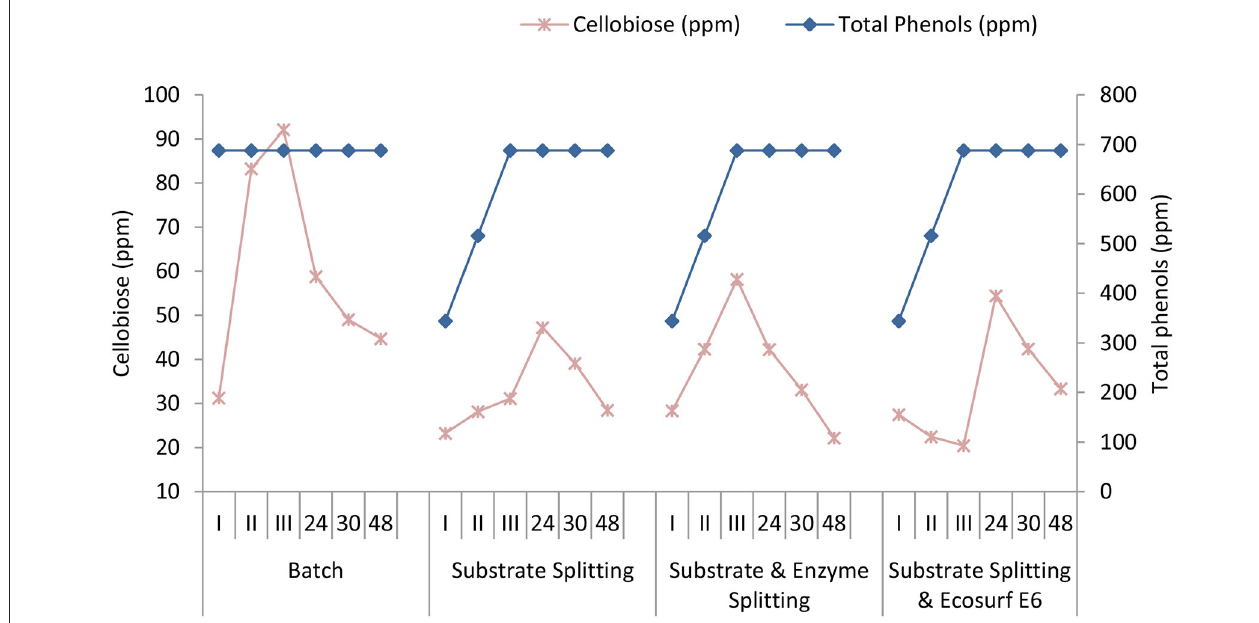
FIGURE 8 | Cellobiose and total phenols during hydrolysis under different modes.